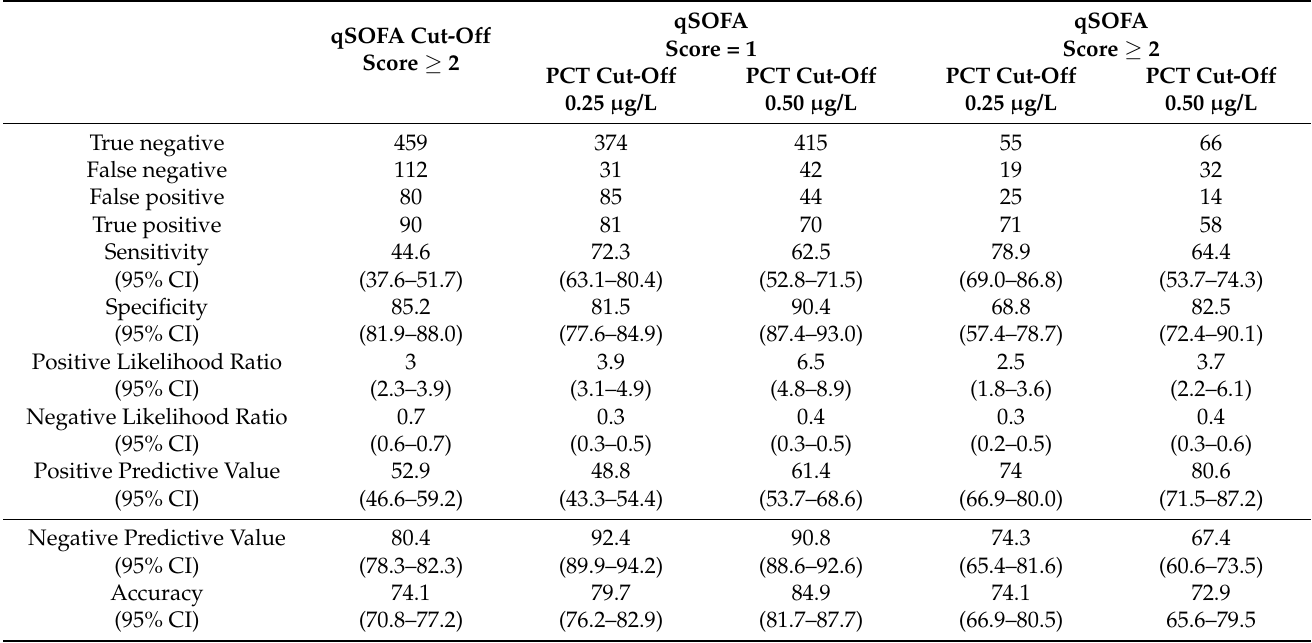
Table 3. Diagnostic performance of qSOFA at a cut-off value of 2 and PCT at different cut-off values within qSOFA categories for the diagnosis of sepsis within 96 h of admission. 95%-CI, 95% confidence intervals.